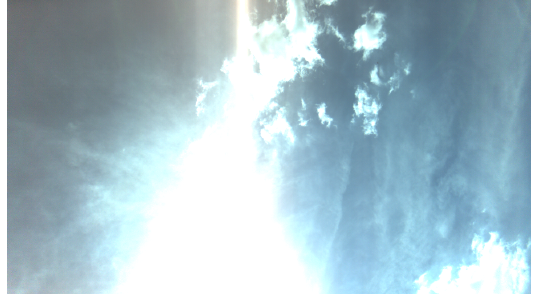
Figure 2: Extracts from images from the urban dataset with visi- ble radiometric artifacts: bloom and overexposure.